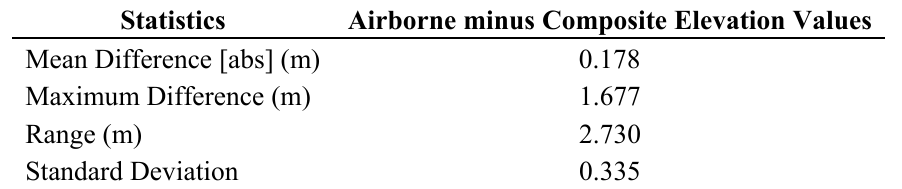
Table 4. Difference in elevation values between the bare-earth airborne and composite LiDAR TIN datasets at 120 random locations throughout the study region. Values were determined by subtracting the composite elevation values from the airborne elevation